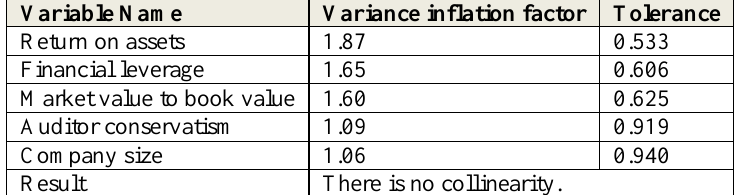
Table 13. Co-linear test of independent variables [Third